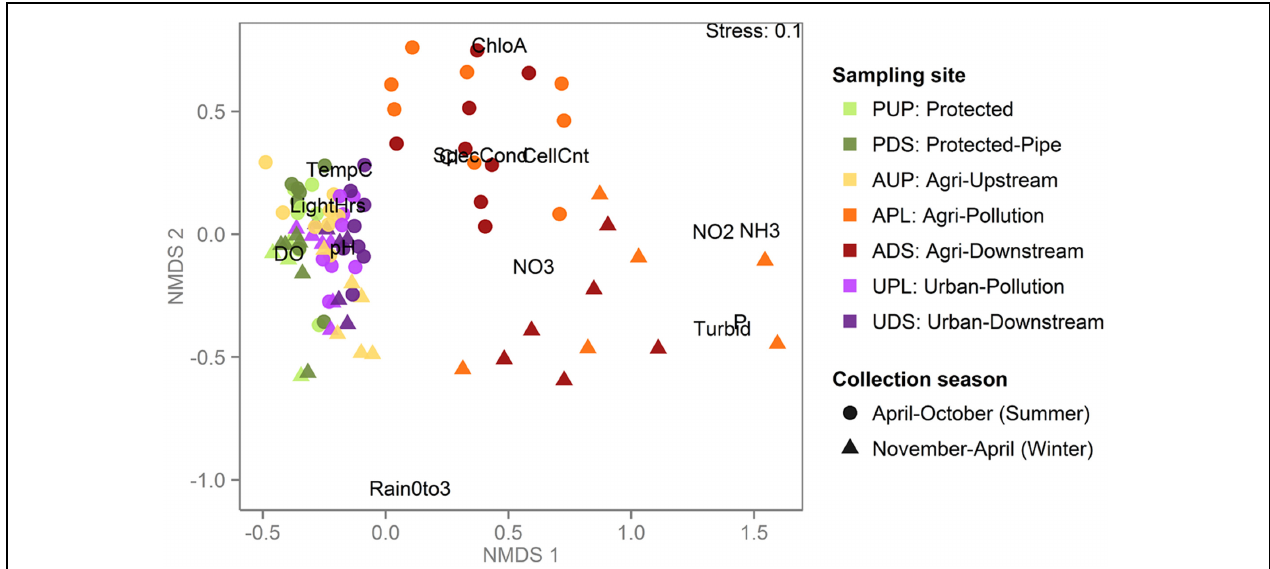
FIGURE 1 | Agriculturally affected sites are distinct from protected and urban sites when clustered by water chemistry and environmental variables. Non-metric multidimensional scaling (NMDS) plot based on environmental and chemical water measurements in which each point represents a sample, colored by sampling site and shaped by season during which the sample was collected. Environmental measures are abbreviated as in Table 2 . Samples from the agriculturally affected sites (APL and ADS) are most distinct, with summer and winter samples mostly clustering together, reflecting the winter’s increased rain and consequent agricultural runoff. All other samples are more similar to each other than to the agriculturally affected sites, including the samples from the agricultural watershed that were collected upstream of agricultural activity